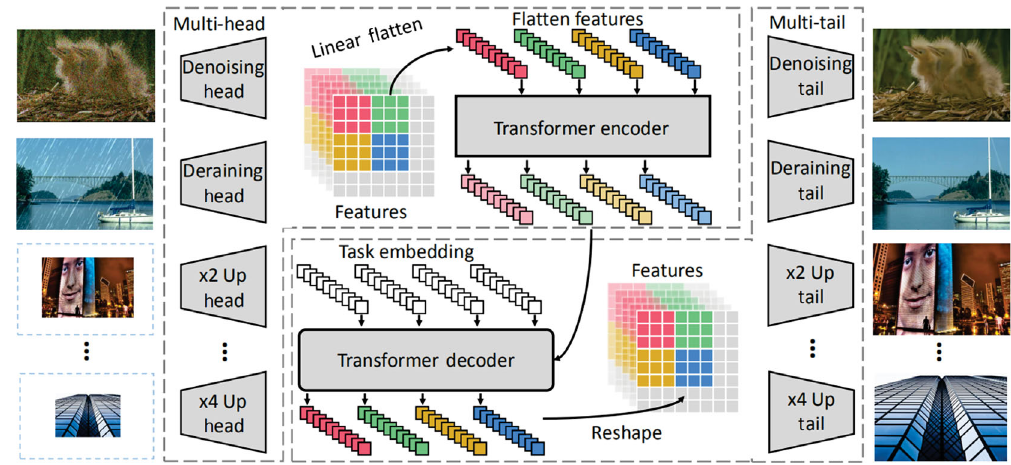
Fig. 15 Overview of IPT. Reproduced with permission from Ref. [101], c (cid:2) The Author(s) 2021.